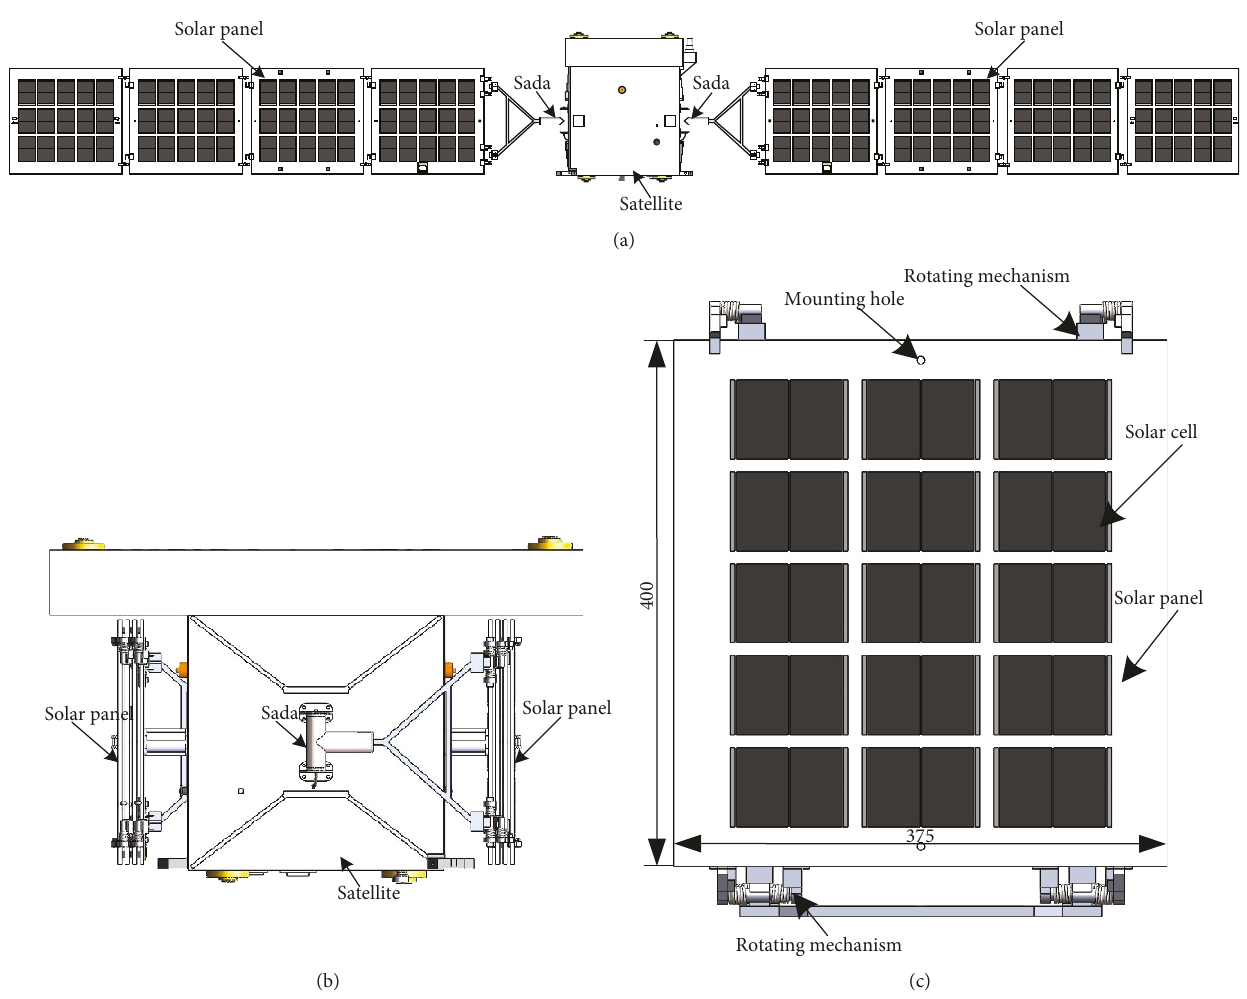
Figure 1: Satellite and solar panel structure: (a) unfolding state, (b) folding state, and (c) solar panel structure.